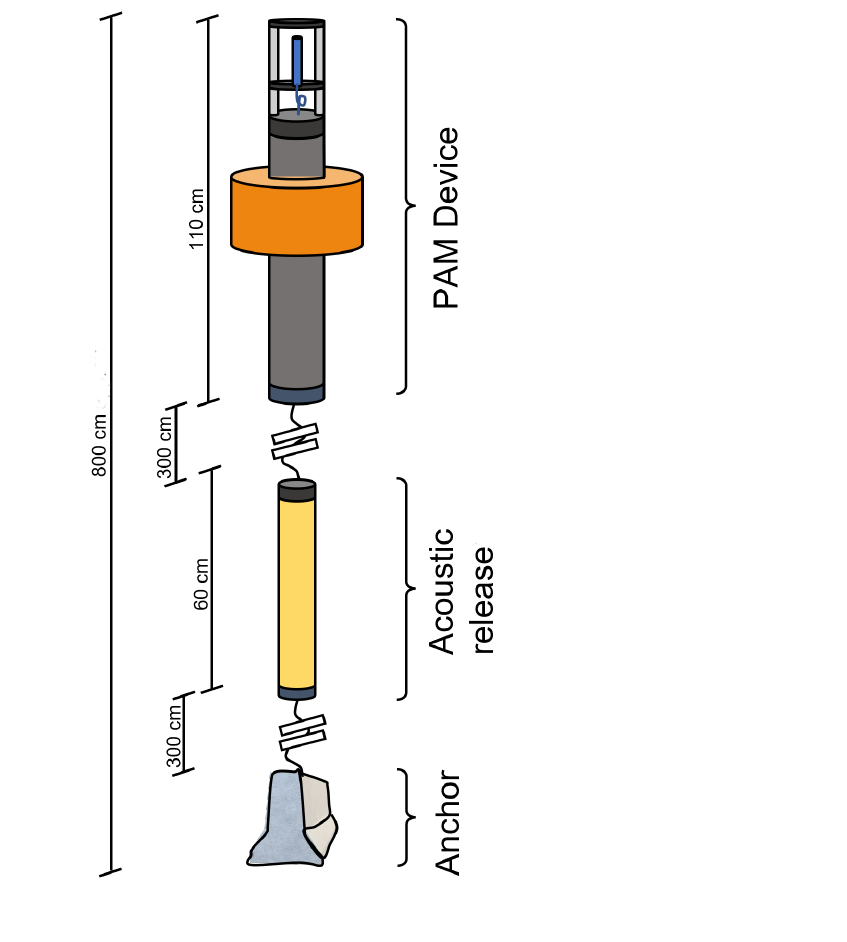
Figure 2. Details of the mooring line experimental setup. It consists of an anchor, an acoustic release, and the passive acoustic recorder integrated into a ringed